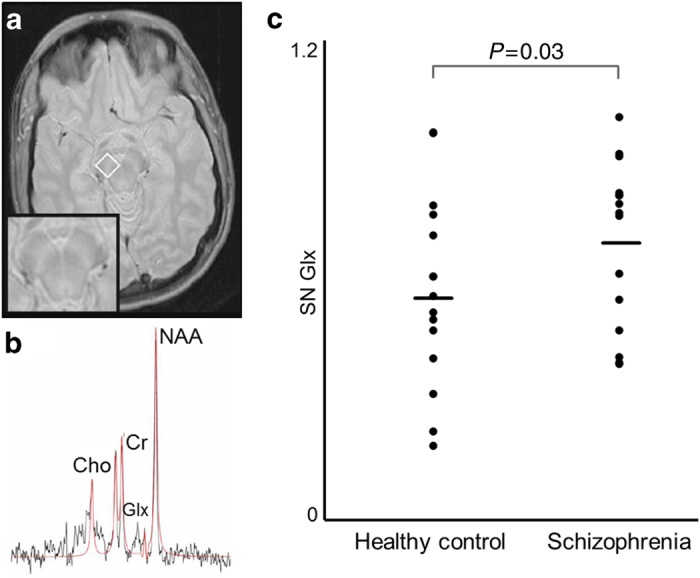
(a) Example of magnetic resonance spectroscopy (1H-MRS) voxel placement in the left substantia nigra (SN; 13×13×13 mm) overlaid on an axial magnetization transfer contrast image. Insert shows the midbrain without the 1H-MRS voxel. Images are displayed in neurological convention. (b) Sample 1H-MRS spectrum obtained from the left SN; the black line is a spectrum (640 averages), the red line is an overlay of the spectral fit. Cho, choline; Cr, creatine; Glx, glutamate+glutamine; NAA, N-acetyl-aspartate. (c) Glx in the left SN in healthy controls and patients with schizophrenia. Horizontal lines indicate group means.